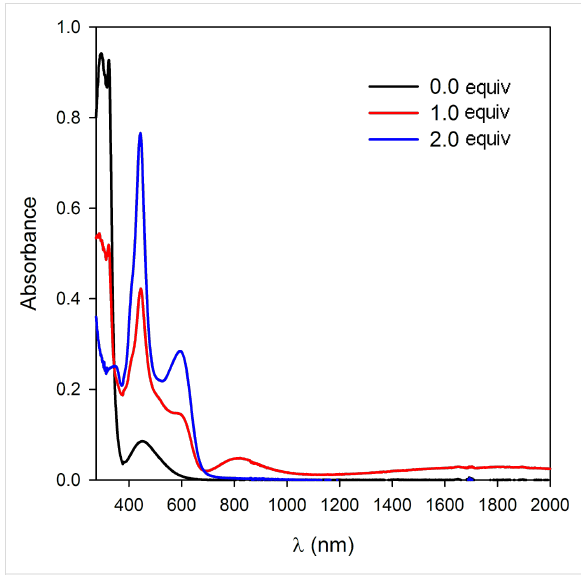
Figure 5: Chemical oxidation of molecular clip 1 (10 − 4 M, CH 2 Cl 2 ) using aliquots of NOSbF 6 oxidizing reagent (5 × 10 − 3 M, CH 3 CN).